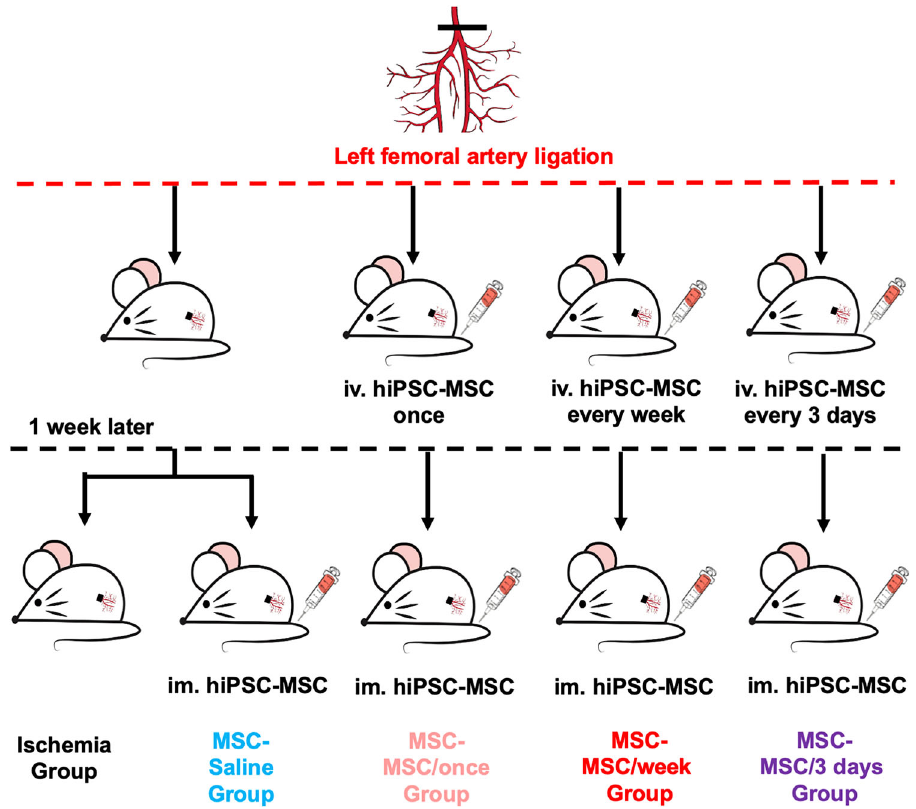
Fig. 2 Flow chart of the experiment. There are fi ve groups of ICR mice in main experiment: ischemia group, MSC-Saline group, MSC-MSC/once group, MSC-MSC/week group, MSC-MSC/3 days